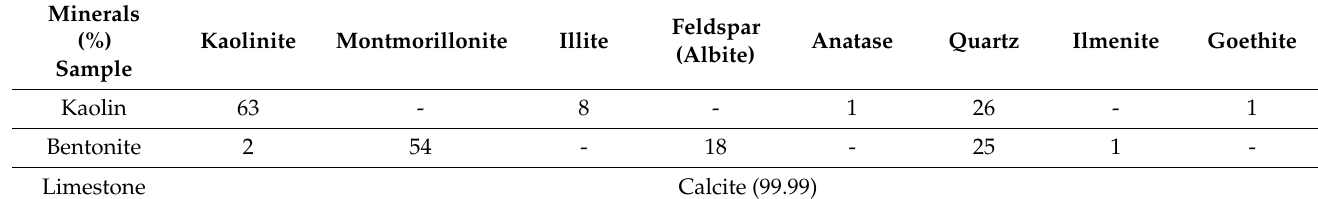
Table 3. Mineralogical composition of the kaolin, bentonite and limestone.